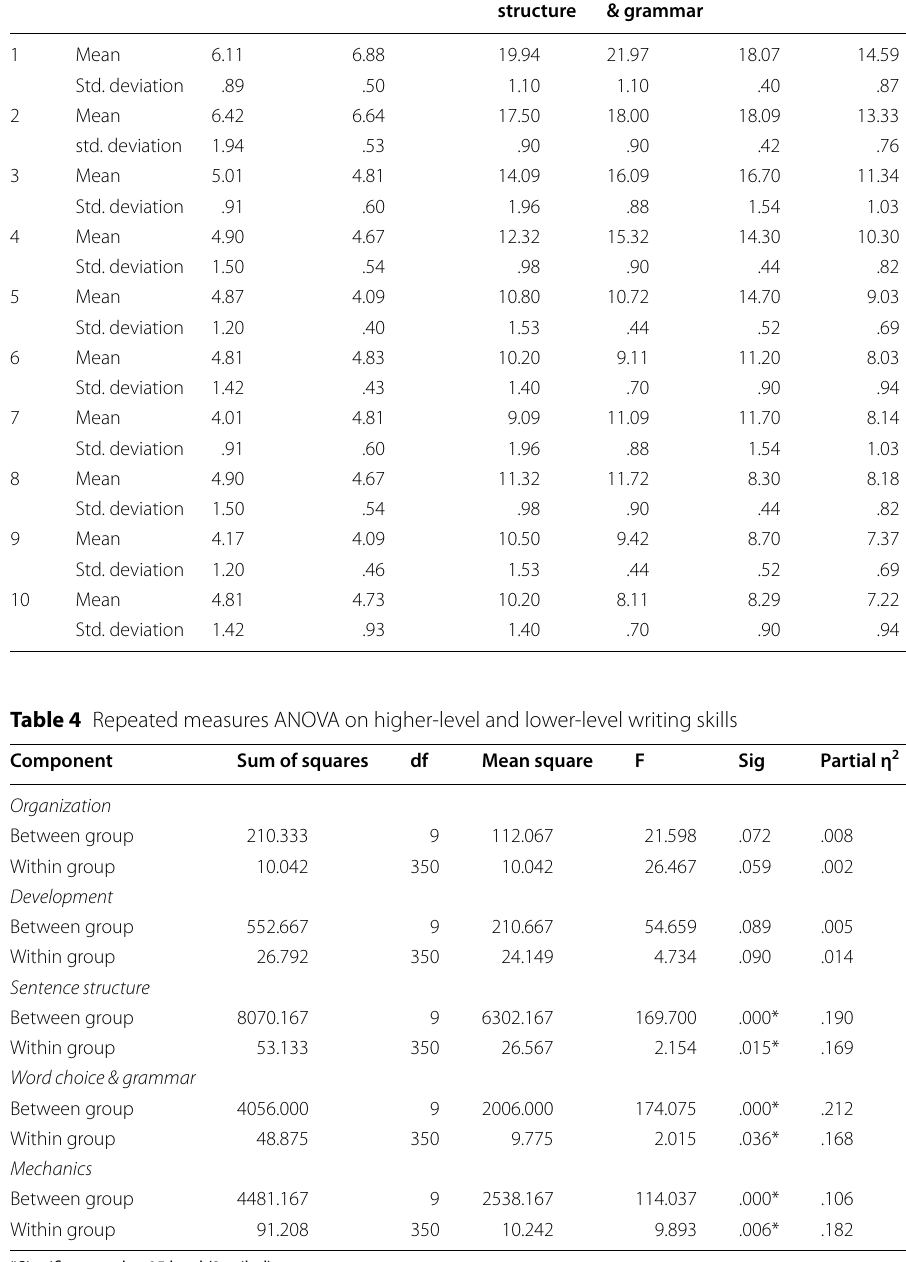
Table 3 Descriptive statistics: higher-level and lower-level skills in collaborative writing tasks Task Statistics Higher‑level skills Lower‑level skills Total Organization Development Sentence Word choice Mechanics structure & grammar